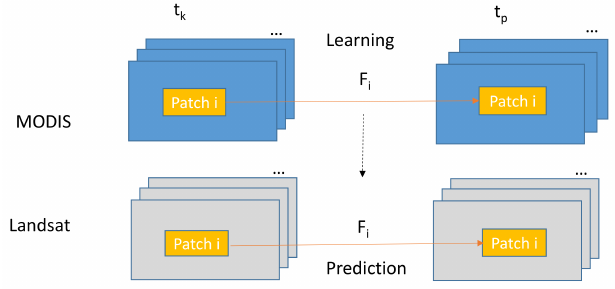
Figure 3. Proposed prediction approach based on local